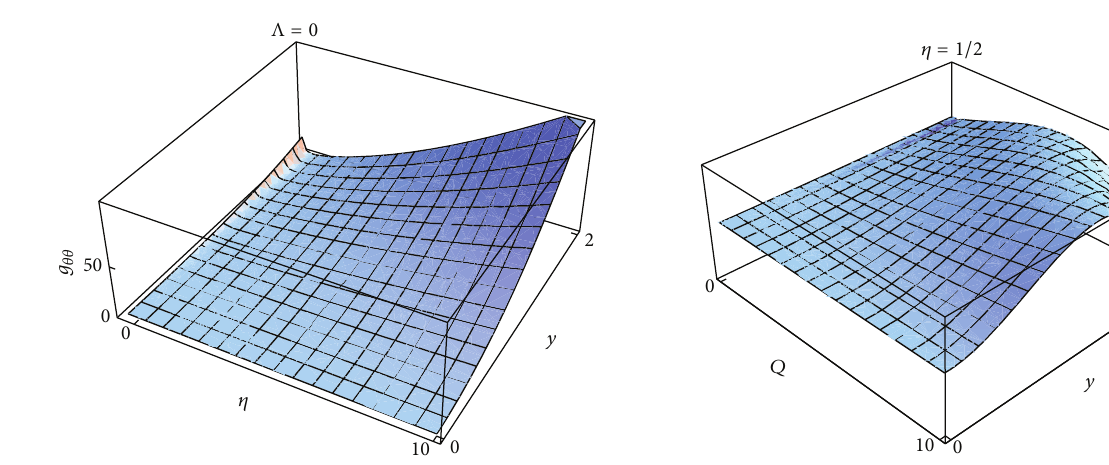
Figure 6: Black string warped horizon area 𝑔 𝜃𝜃 (𝑅,𝑦) along the extra dimension, as a function of 𝑄 𝜂 for 𝜂 = 1/2